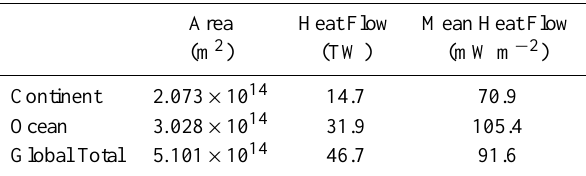
Table 7. Summary of continental and oceanic heat flow from our preferred estimates.